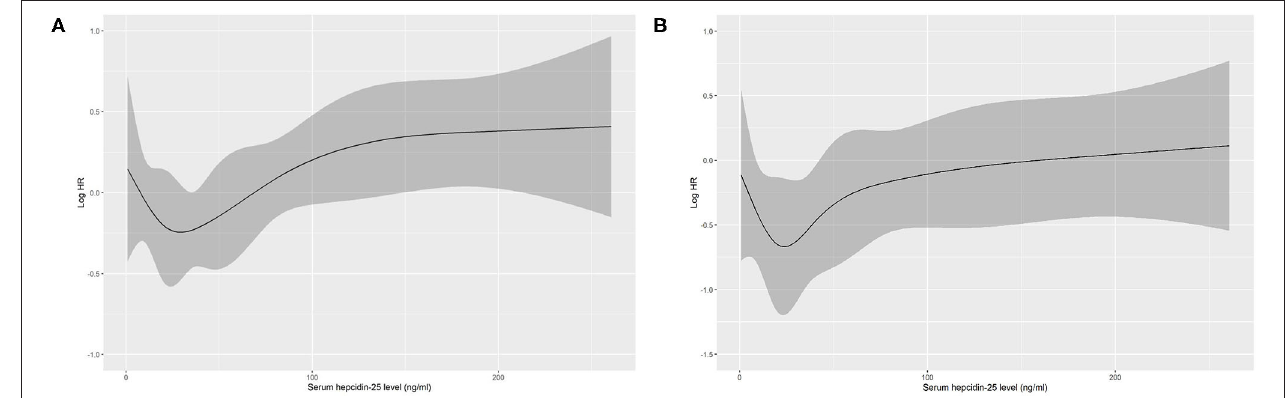
FIGURE 4 | Association of serum hepcidin-25 levels with all-cause mortality in PD patients using restricted cubic spline. Baseline serum hepcidin-25 levels were modeled as a continuous variable, and the model was unadjusted (A) and multivariate (B) adjusted (adjusted for age, gender, body mass index, uric acid, corrected calcium, phosphorus, albumin, comorbidity score, hemoglobin, residual renal function, total Kt/V, high-sensitivity C-reactive protein level, serum ferritin and treatment of erythropoiesis-stimulating agents (ESAs) and/or iron). HR, hazard ratio.